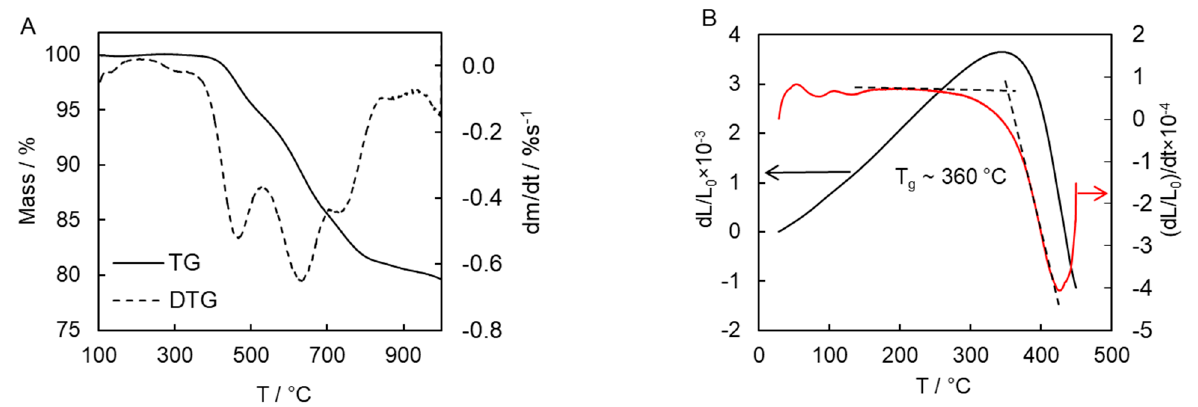
Figure 11. TG and DTG curves of thermal decomposition of polymerization product at 10 °C min − 1 ( A ); TMA measurements for polymerization product ( B ).